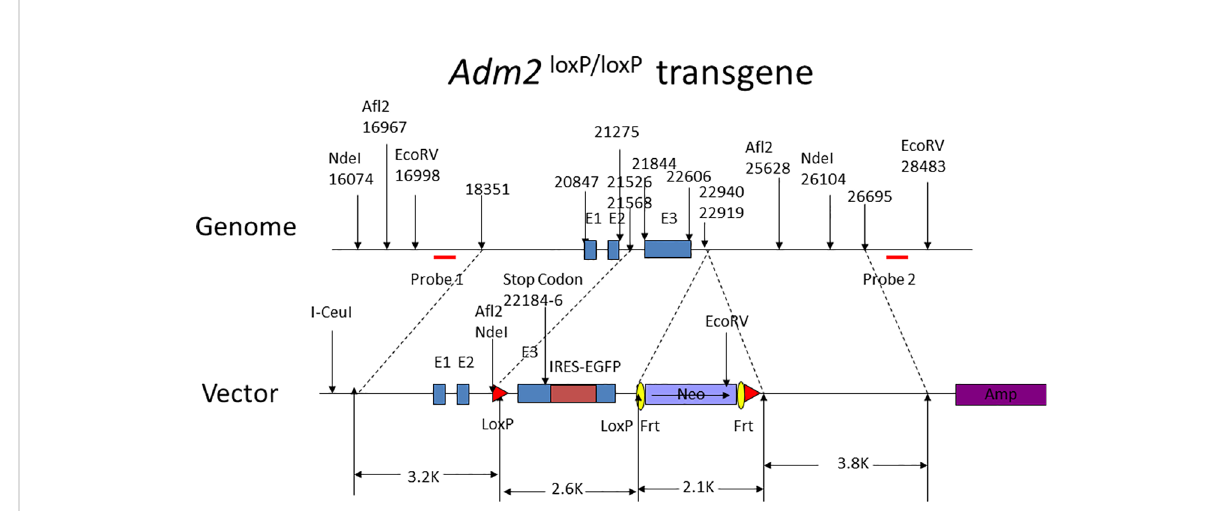
FIGURE 1 Design of the Adm2 loxP/loxP transgene. The nucleotide numbers indicate the relative positions of subcloning sites, exons, and restrictive enzyme cleavage sites. Probes 1 and 2 for the detection of the transgene are indicated by red horizontal bars. The Neo and Amp selection genes are labeled. The exon I, II, and III of the Adm2 gene are labeled as E1, E2, and E3, respectively. The transgene also has an EGFP tag for transgene detection. The I-Ceul site was used to linearize the